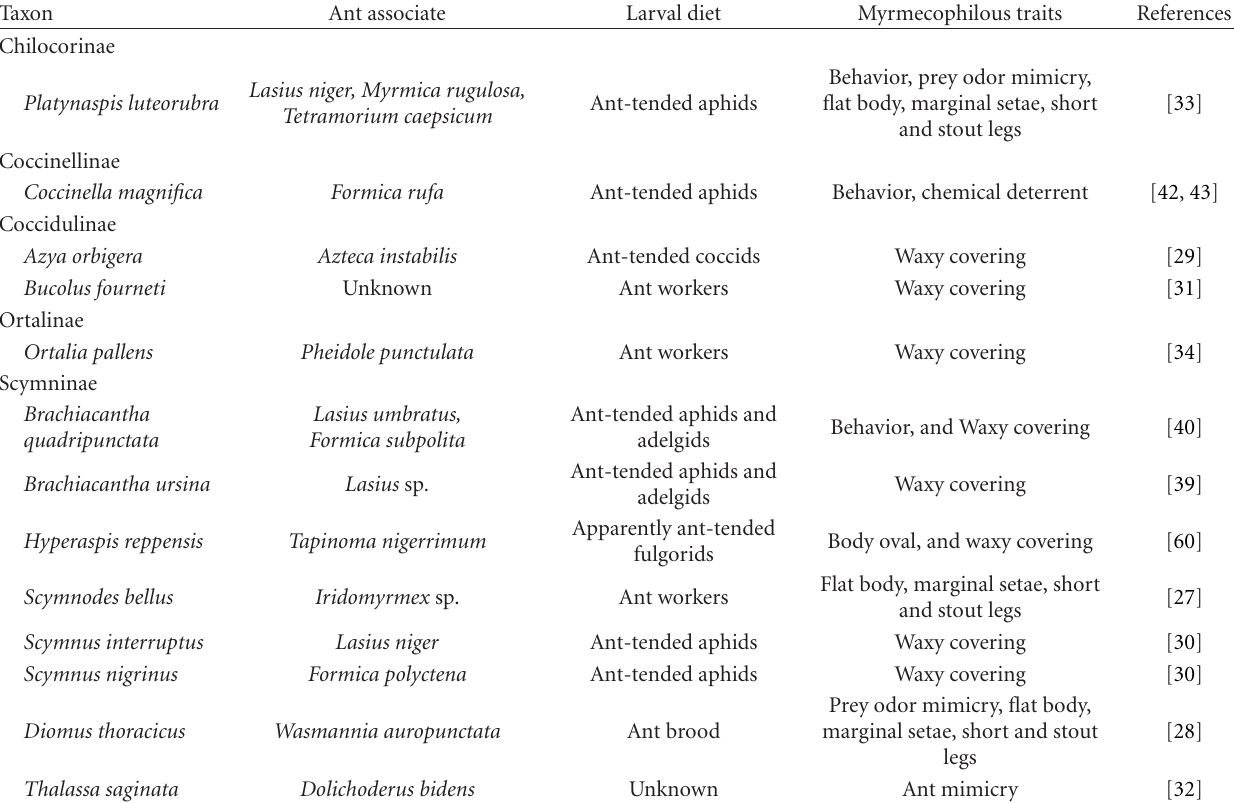
Table 1: Taxonomy and some biological characteristics of myrmecophilous ladybirds. Facultatively myrmecophilous species and species for which no reliable information is available are not